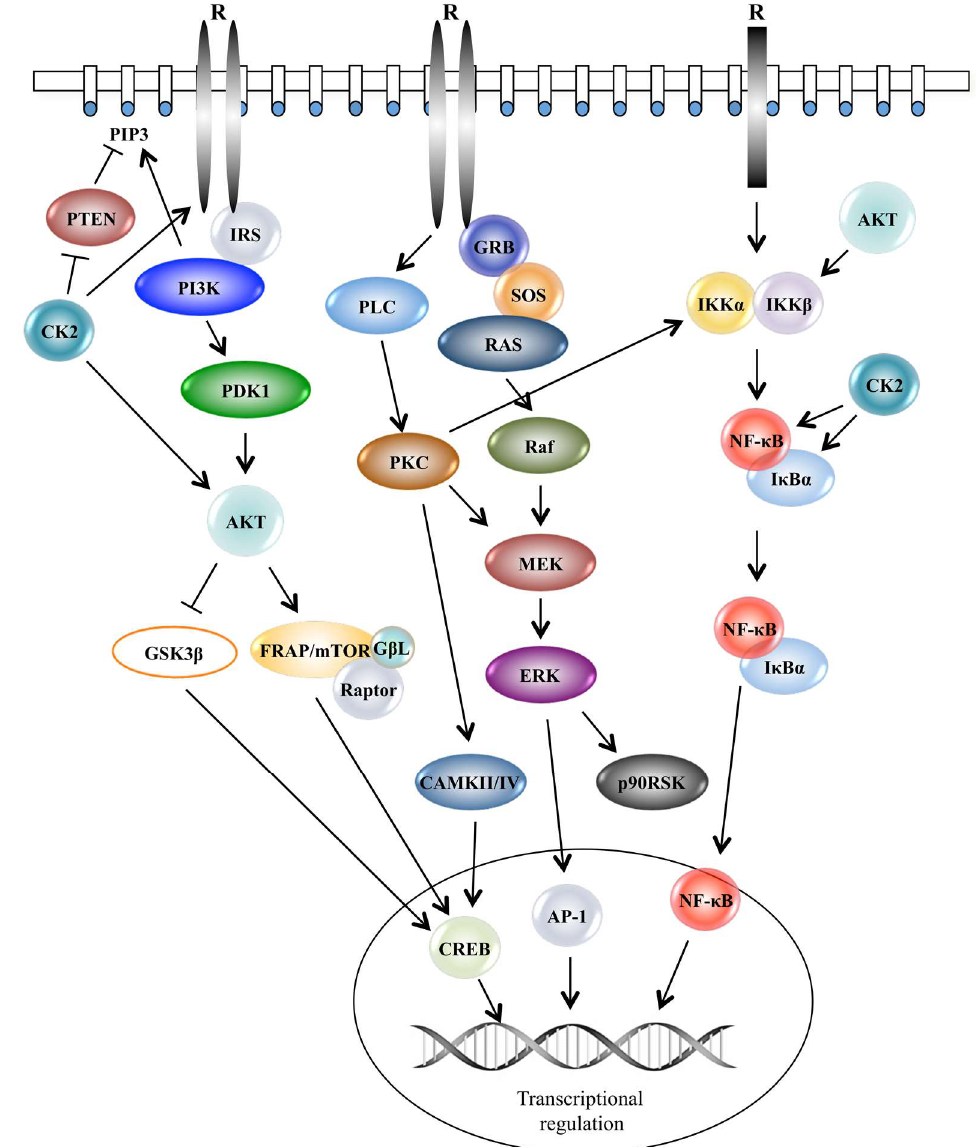
Figure 1. Schematic representation of intracellular signal transduction pathways supporting cell proliferation and survival. Activation of the PI3K/AKT/mTOR, RAS/Raf/MEK/ERK and IKK/NF-κB pathways occurs following a stimulus represented by a ligand, which binds a receptor tyrosine kinase located on the plasma membrane. These pathways control gene expression in a number of ways comprising phosphorylation of transcription factors and co-factors and modification of protein-binding DNA. R: Receptor; PTEN: phosphatase and tensin homolog; IRS: insulin receptor substrate; PI3K: phosphatidylinositol-3-kinase; PDK1: phosphoinositide-dependent-kinase-1; CK2: protein kinase CK2; AKT: protein kinase B; GSK3β: glycogen synthase kinase 3; FRAP/mTOR: 12-rapamycin-associated protein 1/mammalian target of rapamycin; GβL: G protein beta subunit-like; GRB: growth factor receptor-bound protein 2; SOS: son of sevenless; Raf: rapidly accelerated fibrosarcoma; PKC: protein kinase C; MEK: mitogen-activated protein kinase; ERK: extracellular signal-regulated kinase; CAMKII/IV: calcium-calmodulin kinase II/IV; p90RSK: p90 ribosomal s6 kinase; IKKα: IκB kinase α-subunit; IKKβ: IκB kinase β-subunit; NF-κB: nuclear factor-kappa B; IκBα: inhibitor of kappa B; AP-1: activator protein-1; CREB: cAMP response element-binding protein.